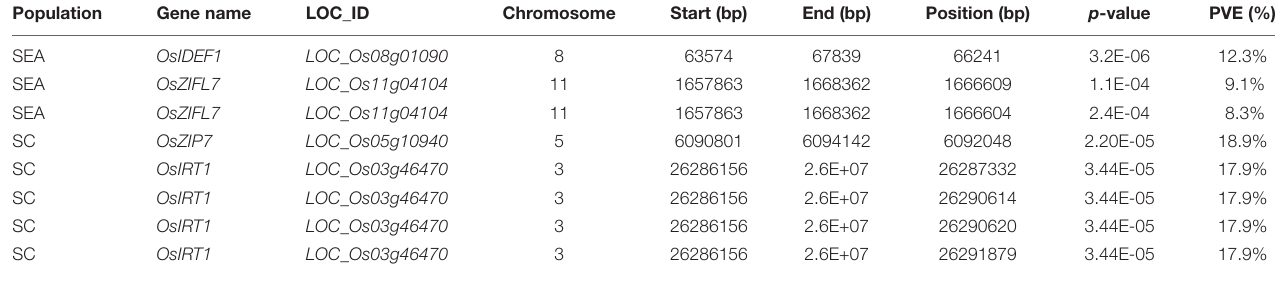
TABLE 1 | List of detected grain Zn content-associated genes in SEA and SC panels based on the SL-MLM model. Population